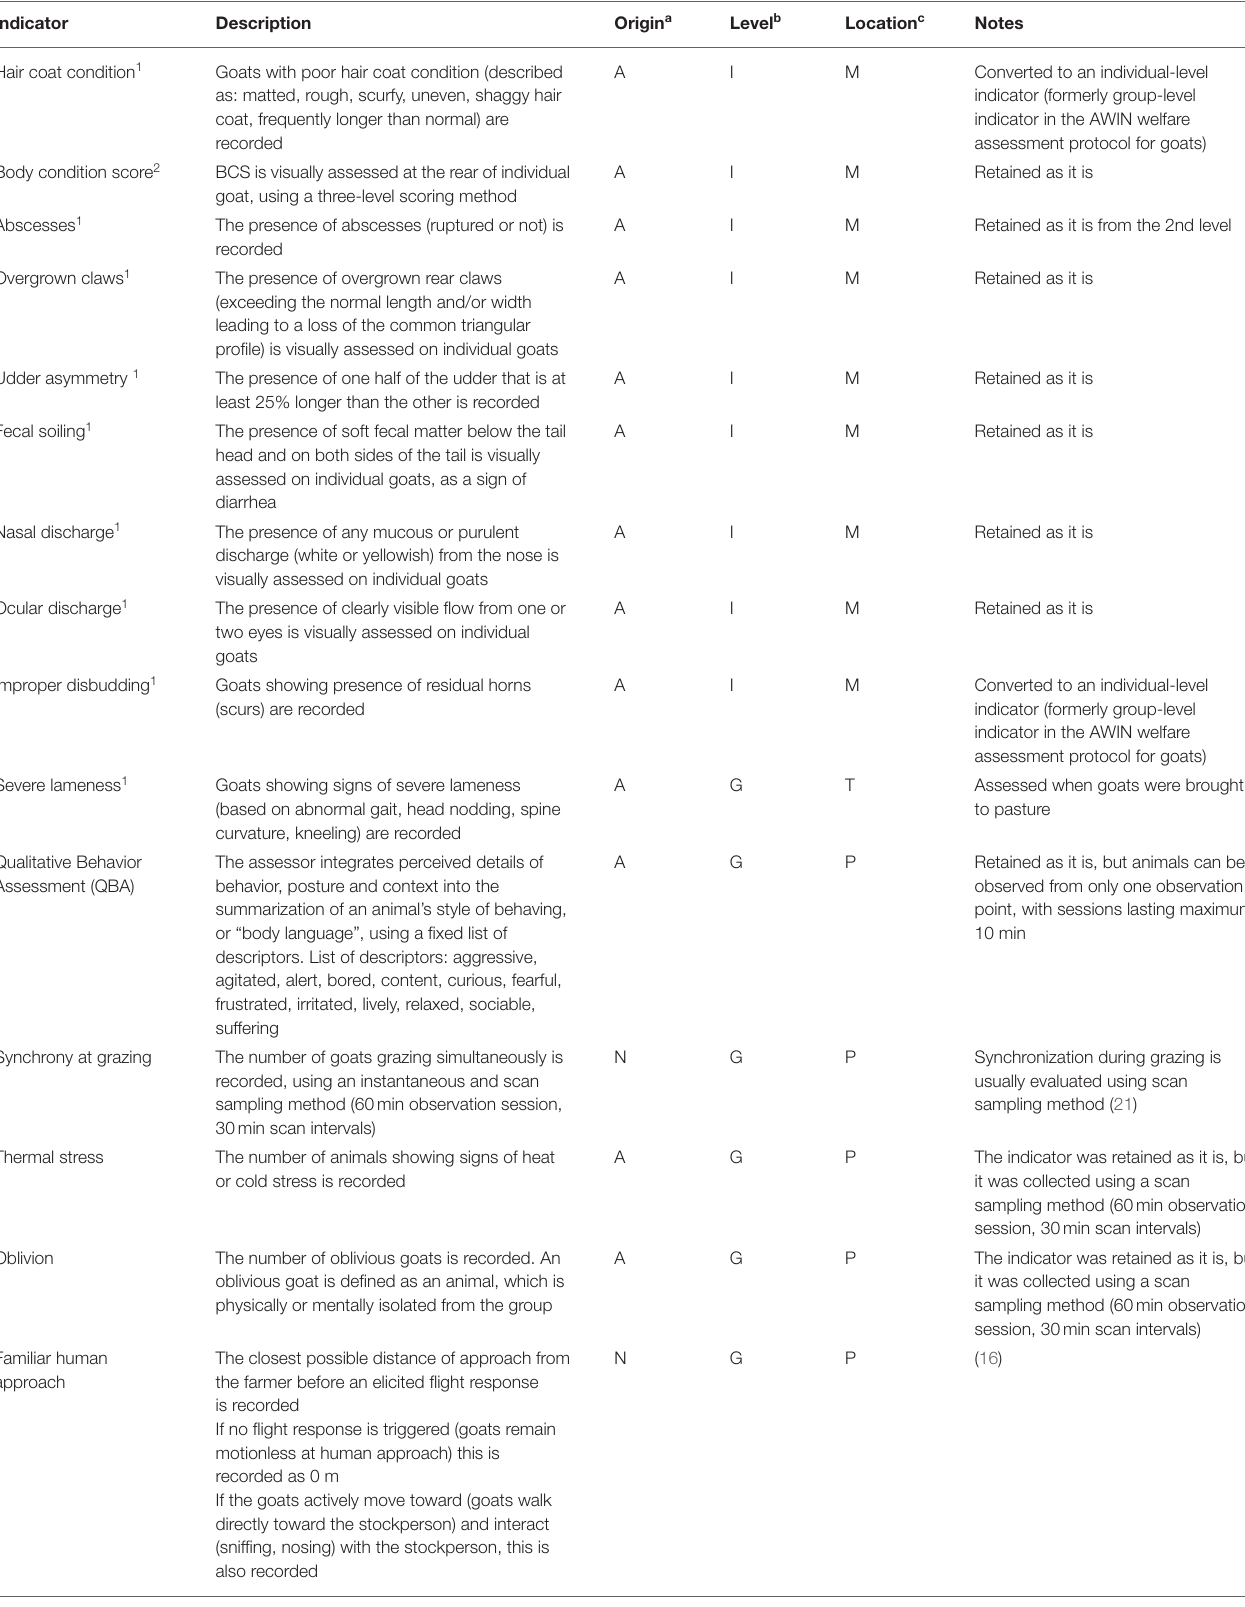
TABLE 1 | Indicators applied for refining the AWIN welfare assessment protocol for goats to semi-extensive farming conditions.